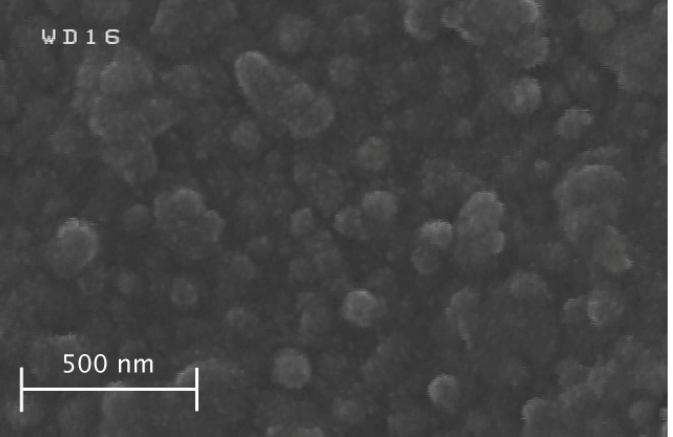
Figure 9 . Top FESEM image of the thin film sample after sulfurization (Sample G3). Figure 9. Top FESEM image of the thin film sample after sulfurization (Sample